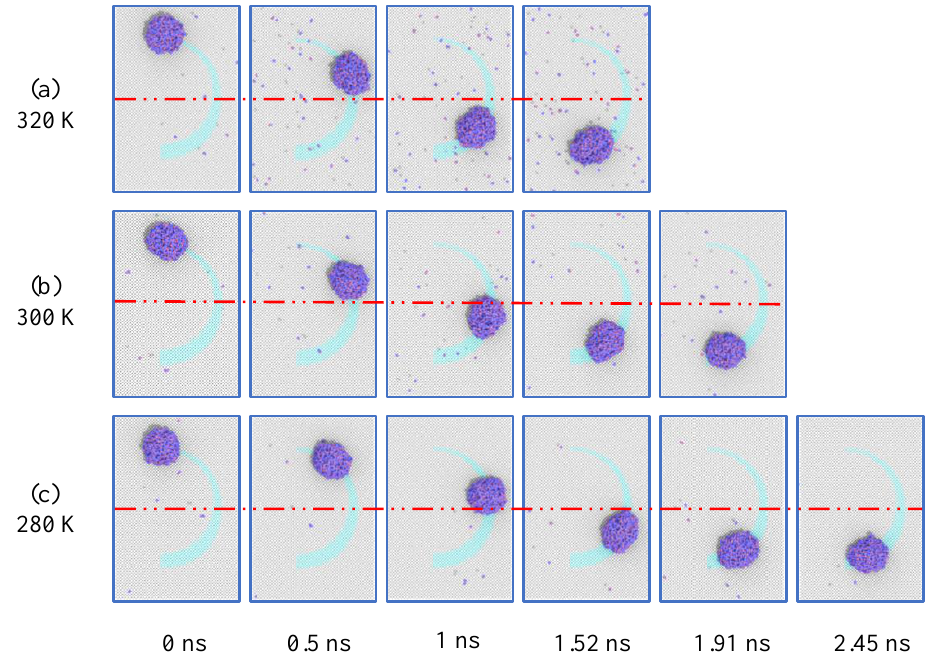
Figure 9. Instantaneous pictures of droplet motion at different temperatures. ( a ) 320 K; ( b ) 300 K; ( c ) 280 K. Red center line is marked to assist in observing droplet movement.